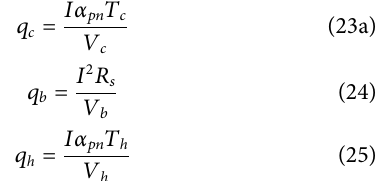
Frontiers in Energy Research |